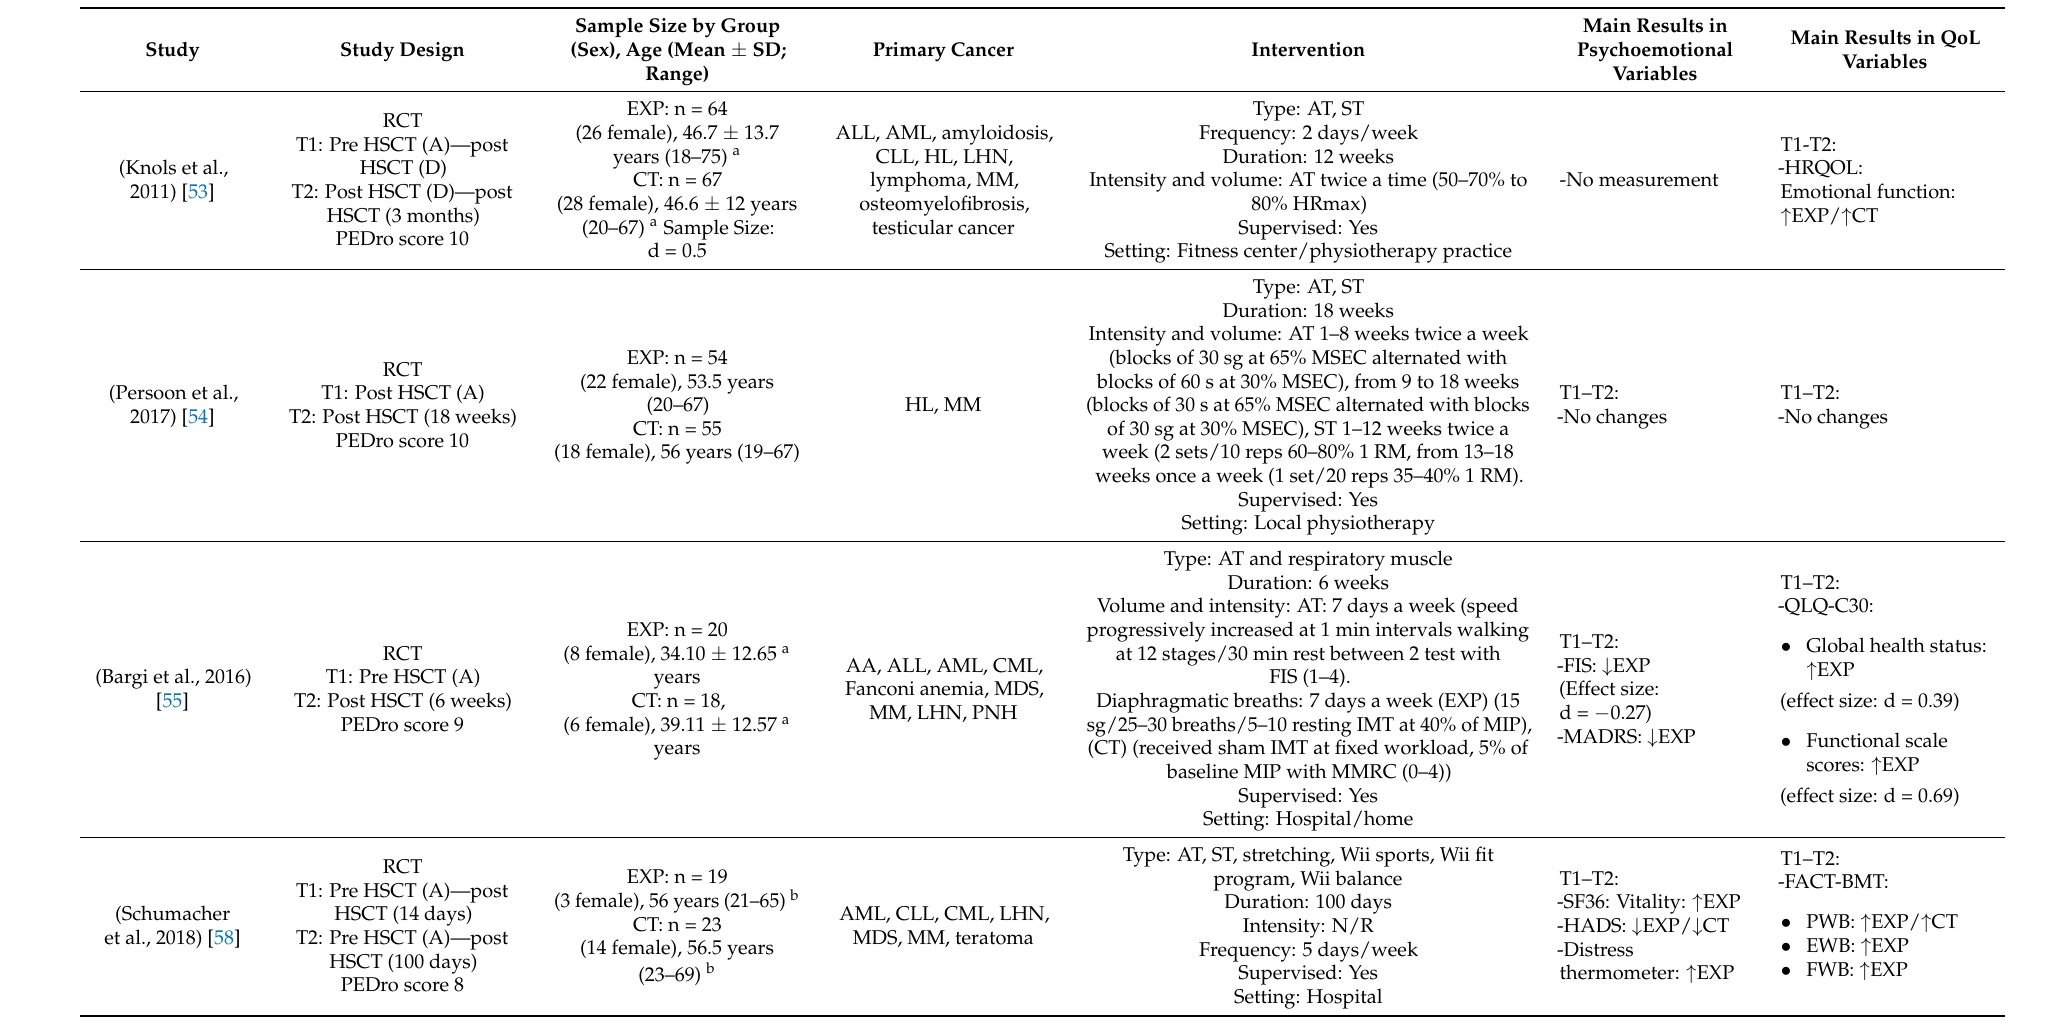
Table 3. Studies that have analyzed the effects of an exercise program after HSCT, with the main results in quality of life and other psycho-emotional related variables. (All the studies were order by PEDro score from largest to